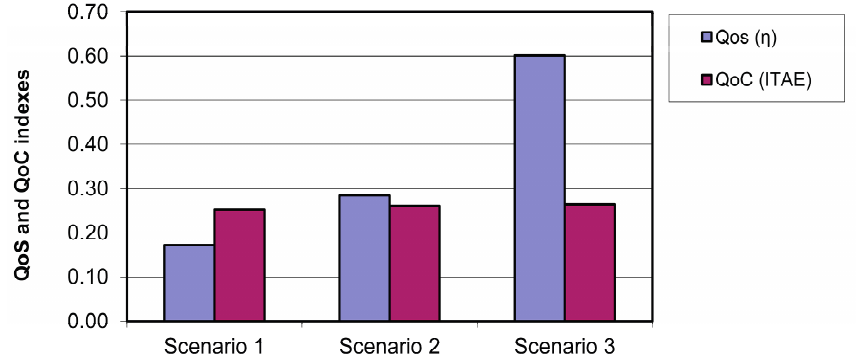
Figure 22. Comparison chart between the η values (QoS) and the ITAE values